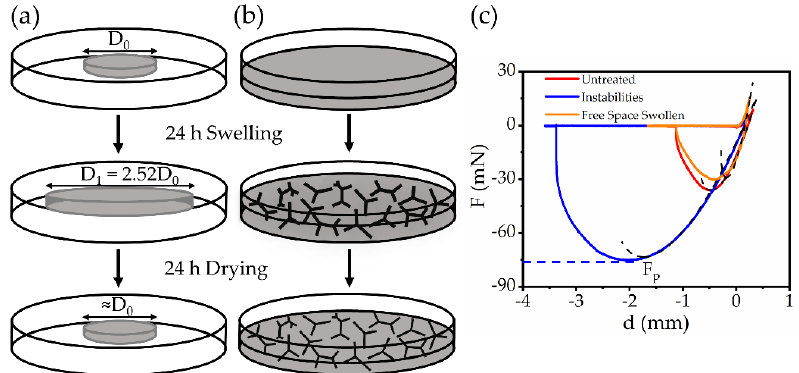
Figure 4. Adhesion tests on the gel substrates. ( a ) Schematics of the swelling process in free space. ( b ) Schematics of the swelling process in a confined Petri-dish. ( c ) The force – displacement curves in the indentation measurements for the untreated samples (red), the free swollen samples (orange), and the samples with instabilities (blue). The indenter used in the measurements was a steel spherical probe with a 16 mm diameter. The dashed black lines are the best fits of the JKR model to the experimental results.